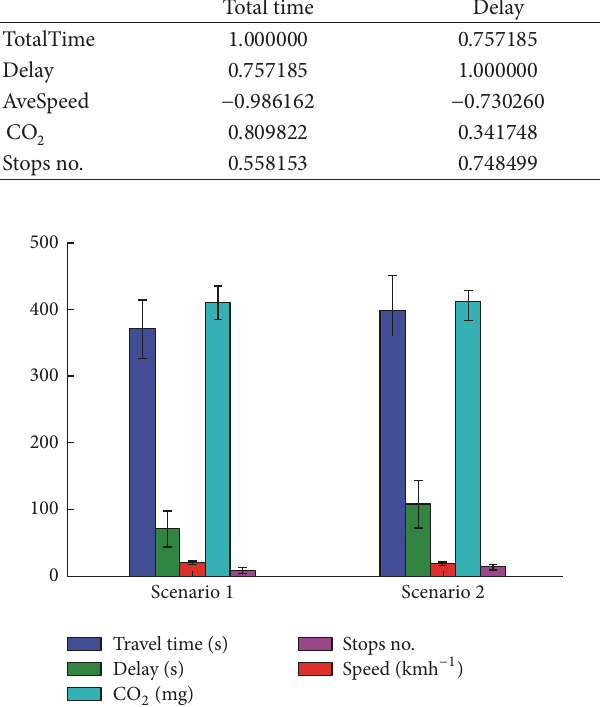
Figure 7: Comparison of the average variable values in Scenario 1 (with TLA) and Scenario 2 (without